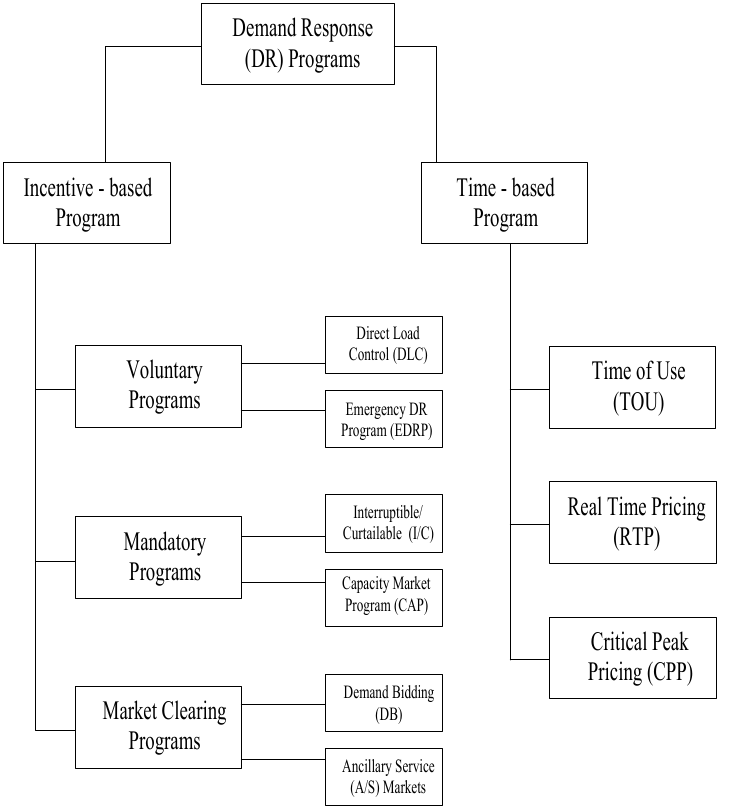
Figure 3. Demand Response programs classifications